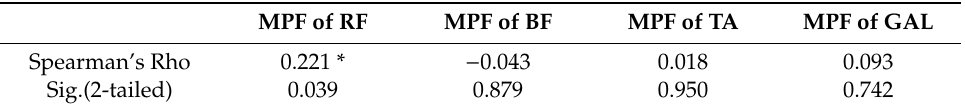
Table 6. The correlation between MPF and subjective fatigue RPE of each targeted muscle in the constant load